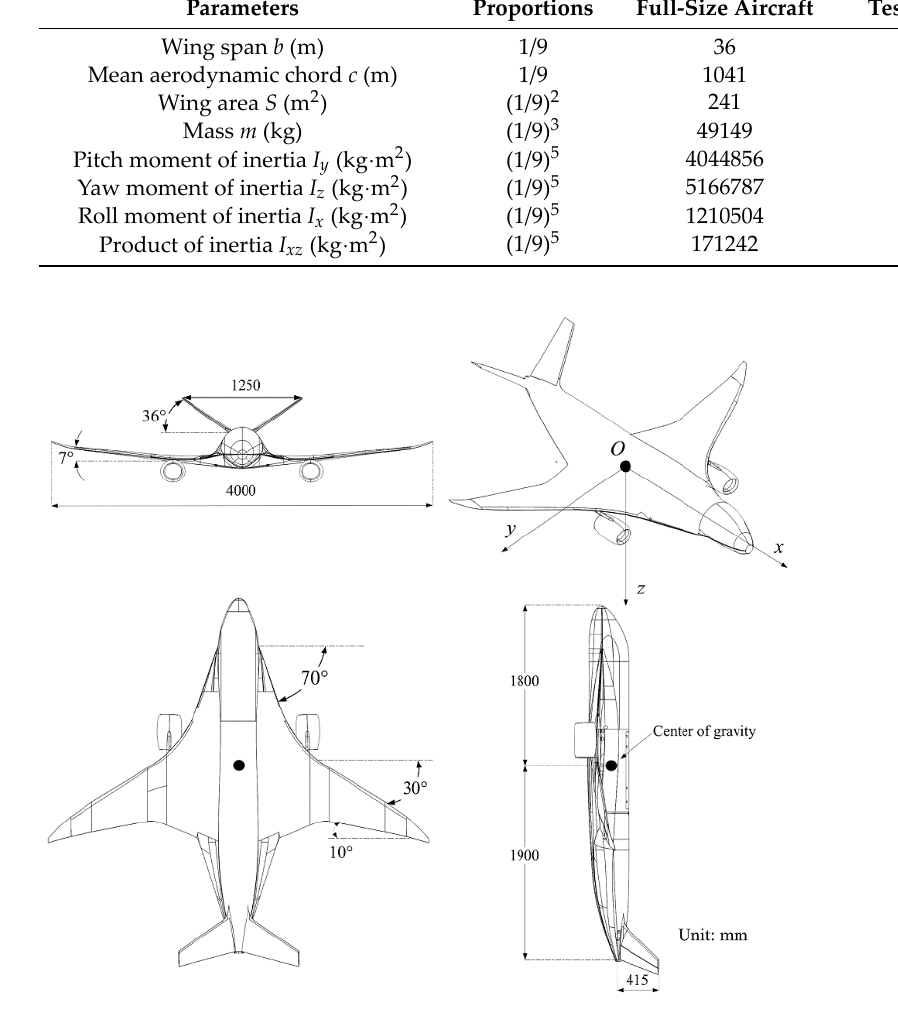
Figure 7. Schematic diagram of the measurement and control system for wind tunnel virtual flight test. The wind speeds V = 30 m/s and α = 6° are selected as the trim flight state in the wind tunnel. Through the traditional wind tunnel force test on the test model, the aerodynamic database of the model at a speed of 30 m/s is obtained, as shown in Figure 8. In the tradi- tional wind tunnel test carried out in this paper, the support interference correction test is